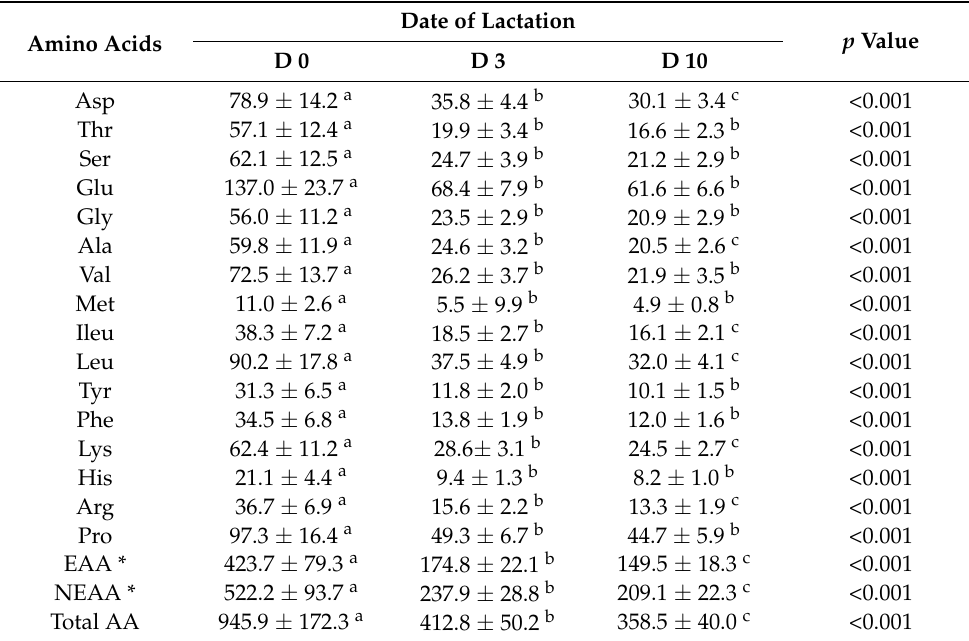
Table 2. Actual amino acid content of sow milk at d 0 (colostrum), 3, and 10 of lactation (mmol/L, n =